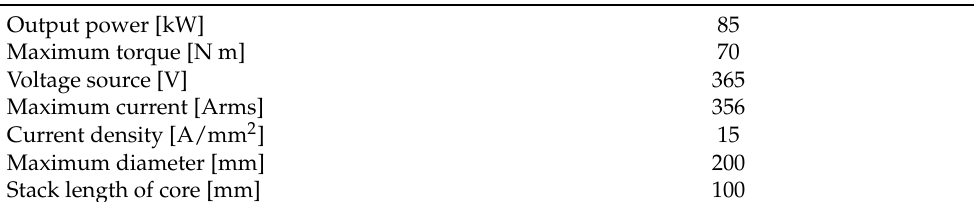
Table 1. Target performances.